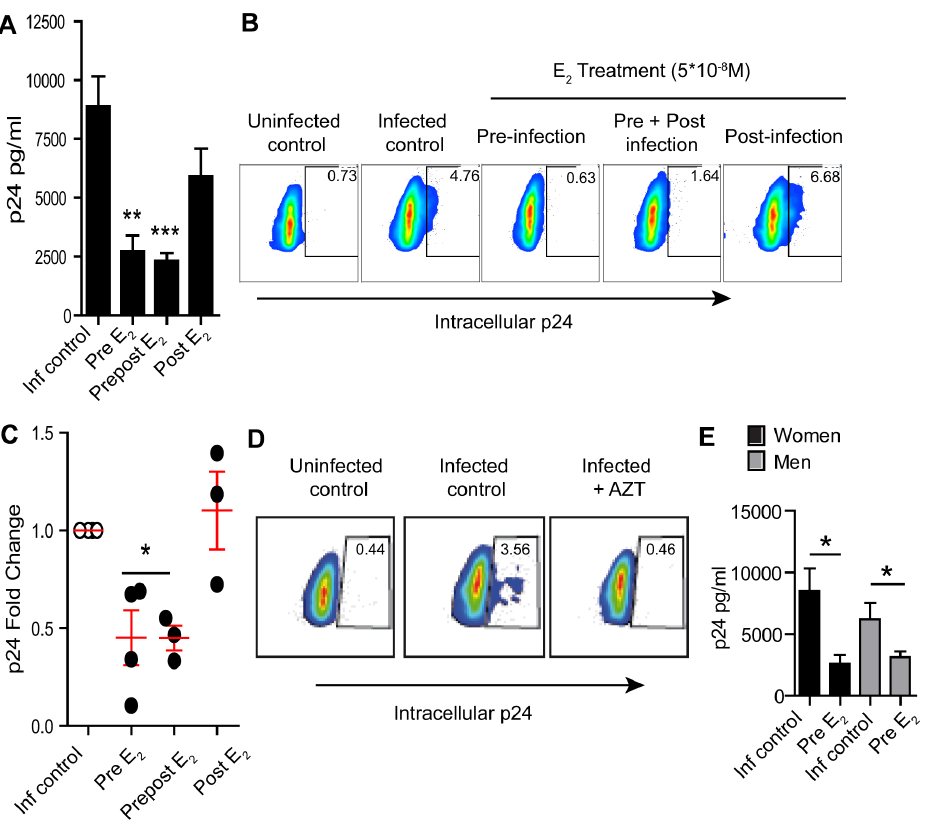
Figure 2. Effect of E 2 on macrophage HIV-infection. A) Released p24 levels in the culture media after 7 days of infection when cells where pre- treated with E 2 (pre E 2 ), treated with E 2 before and after infection (prepost E 2 ) or only after infection (post E 2 ). Bars represent mean 6 SEM from 5 independent experiments with different donors. **P , 0.01;***P , 0.001. B) Representative contour plot of intracellular p24 levels after 7 days of infection and C) Fold change respect infected control of intracellular p24 from 4 different donors. Mean 6 SEM is represented. *p , 0.05. D) Intracellular p24 levels after 7 days of infection in the presence of Zidovudine (AZT). E) Released p24 in the culture media after 7 days of infection in CD4 + T-cells from women (black bars; N=3) or men (grey bars; N=3). *P , 0.05.